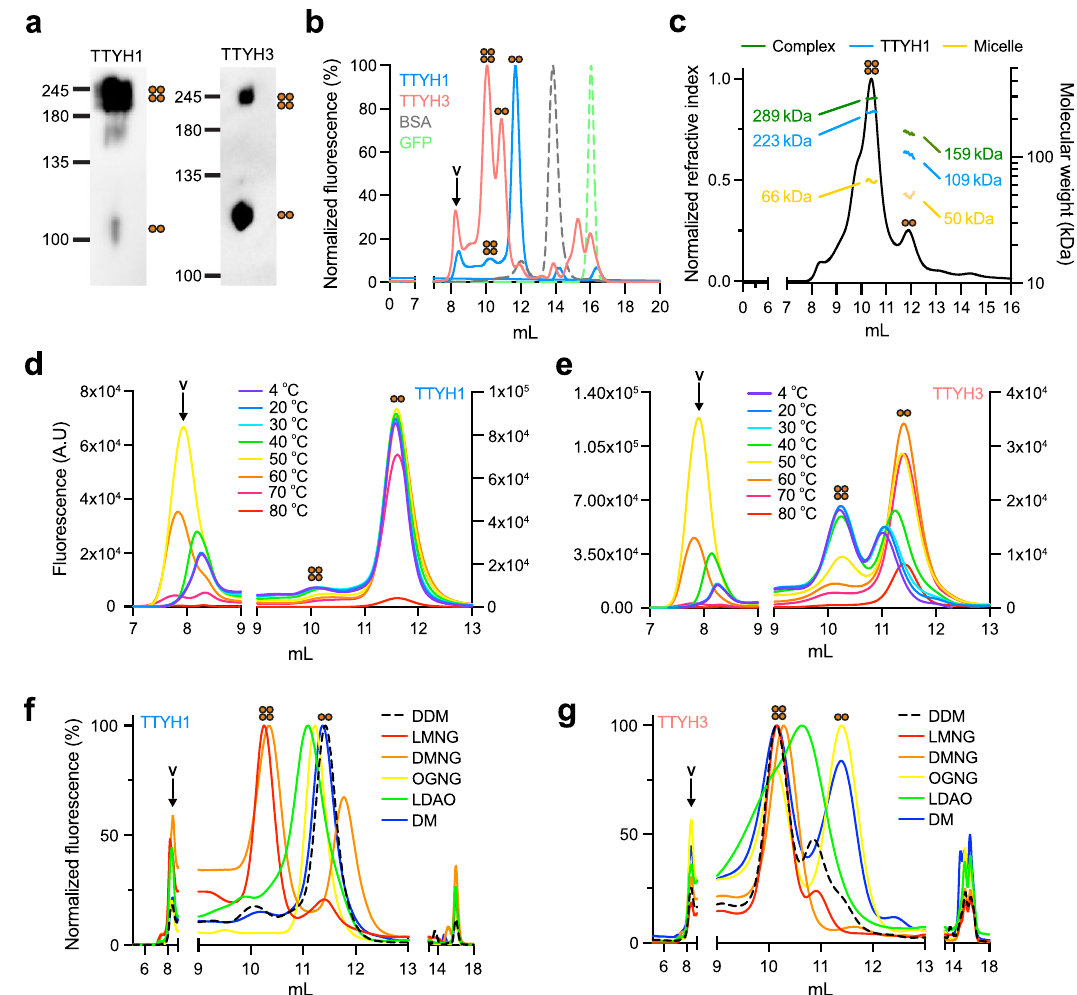
Fig. 3 Analyses of detergent-solubilized mTTYH paralogs. a BN-PAGE western blot analysis of HEK 293 cells transiently transfected with mTTYH1 (left) or mTTYH3 (right). b FSEC chromatograms depicting the elution pro fi les of DDM solubilized HEK 293 cells expressing the indicated EGFP-fused mTTYH paralogs. BSA and EGFP pro fi les are provided for reference. c Puri fi ed mTTYH1-GFP SEC-MALS analysis. The normalized refractive index is shown as a black line, while the calculated masses of the protein, detergent, and protein – detergent complex are shown as blue, yellow, and green lines, respectively. d , e FSEC chromatograms of mTTYH1 ( d ) and mTTYH3 ( e ) preincubated for 10 min at the indicated temperatures. f , g FSEC chromatograms of mTTYH1 ( f ) and mTTYH3 ( g ), solubilized using different detergents, as indicated. Orange circles represent the oligomeric states of the complex. Column void volume (v) is indicated by arrow where